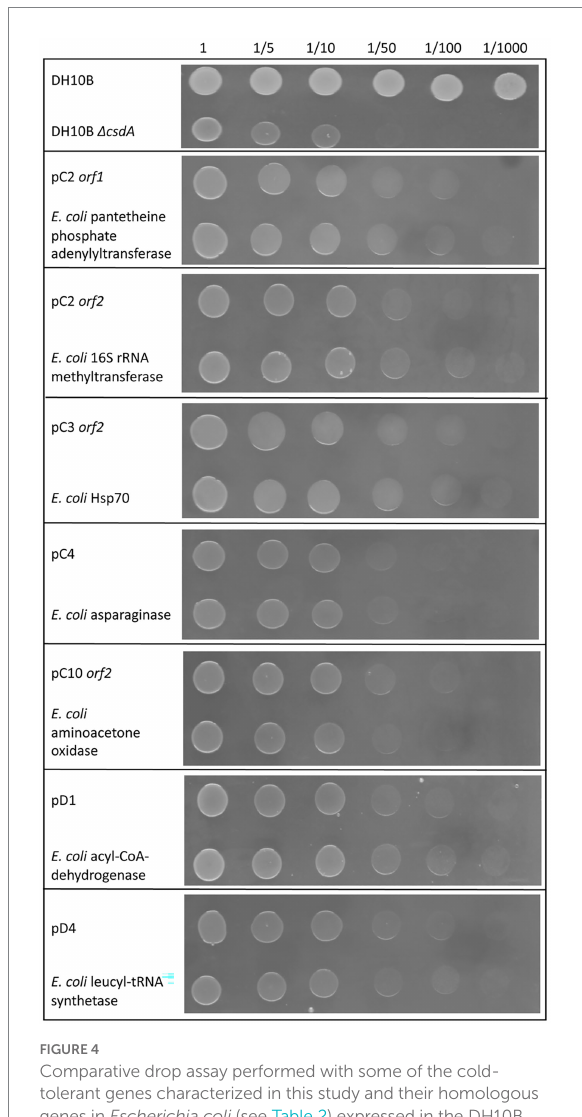
FIGURE 4 Comparative drop assay performed with some of the cold- tolerant genes characterized in this study and their homologous genes in Escherichia coli (see Table 2) expressed in the DH10B Δ csdA strain. DH10B strain carrying an empty pBluescript vector was used as a positive control and the single cold-sensitive mutant (DH10B Δ csdA ) also carrying an empty pBluescript vector was used as a negative control. The cell density of overnight cultures was adjusted to OD 600 nm values of 1.0, serial dilutions were performed and 10 μl drops of each dilution were inoculated on LB-Ap 50 plates and grown at 15 ° C for 10 days. Each experiment was repeated at least three times using independent